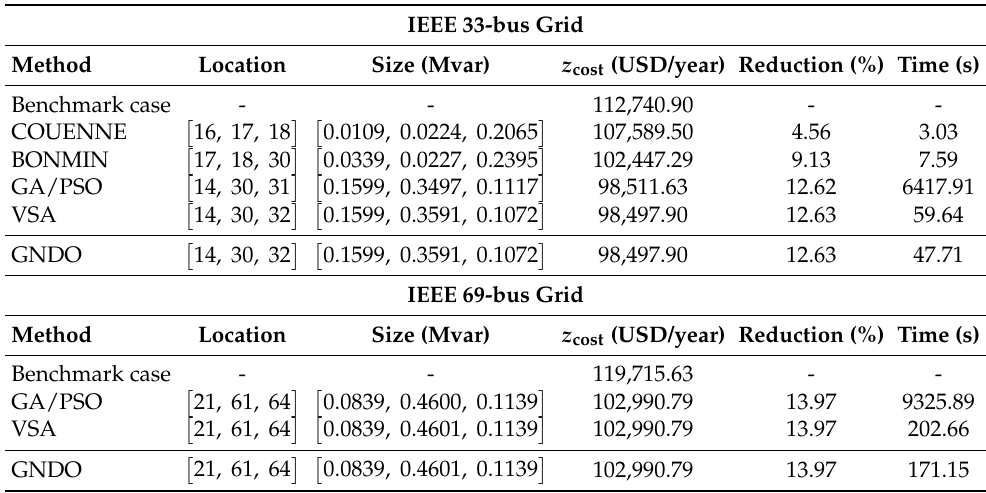
Table 8. Comparative results regarding D-STATCOM location and sizing in the IEEE 33- and 69-bus grids.